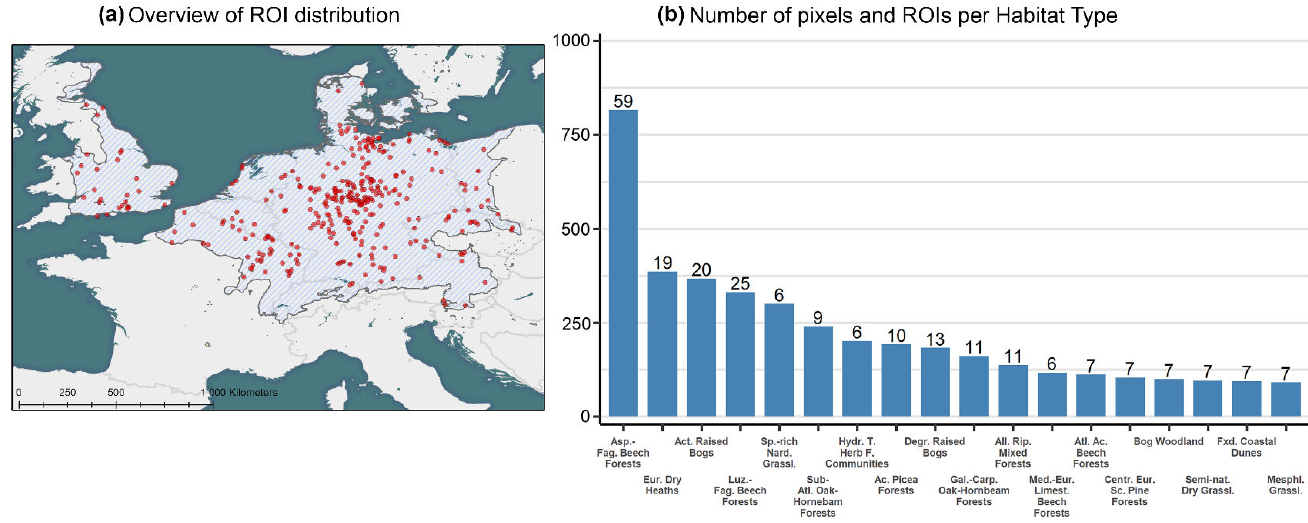
Figure 1. ( a ) Overview of the distribution of SACs that constitute ROIs in all years. ( b ) shows the number of pixels per habitat class. The number of ROIs is shown above the bars. A list of all habitat type abbreviations is shown in Appendix B.